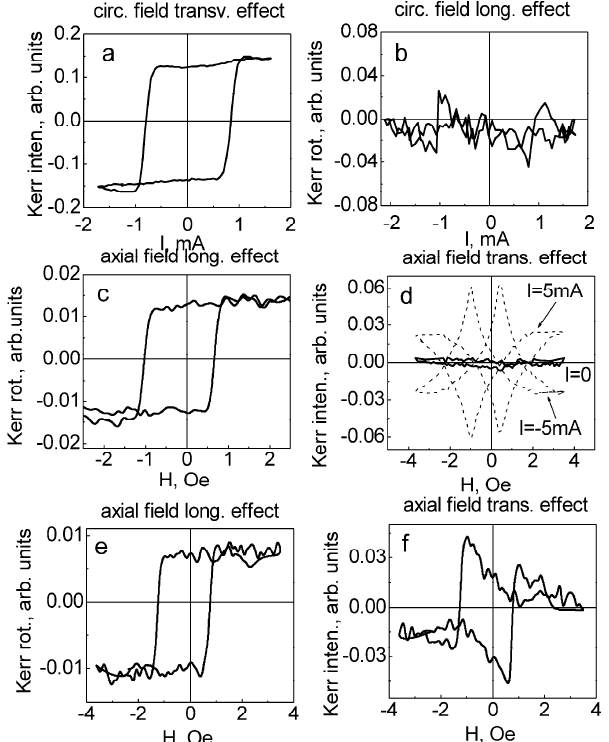
Figure 14. Longitudinal and transverse Kerr effect loops of microwire № 6 for different Mn content: ( a , b ) x = 0.07; ( c , d ) x = 0.11; ( e , f ) x = 0.09. Reprinted with permission from [37].